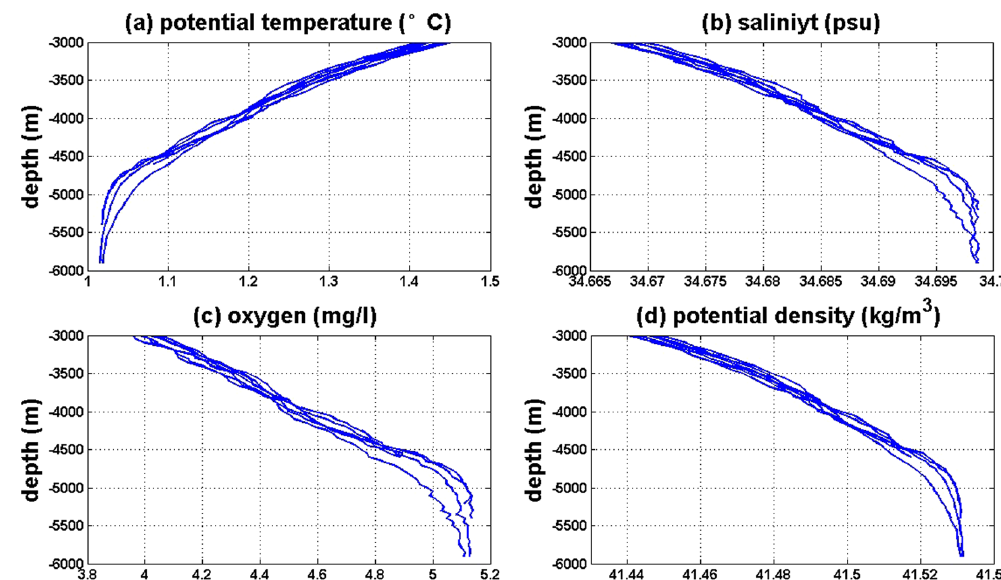
Figure 2. Vertical profiles of potential temperature ( a ), salinity ( b ), oxygen ( c ), and potential density ( d ) of 2016S1. Figures were plotted using